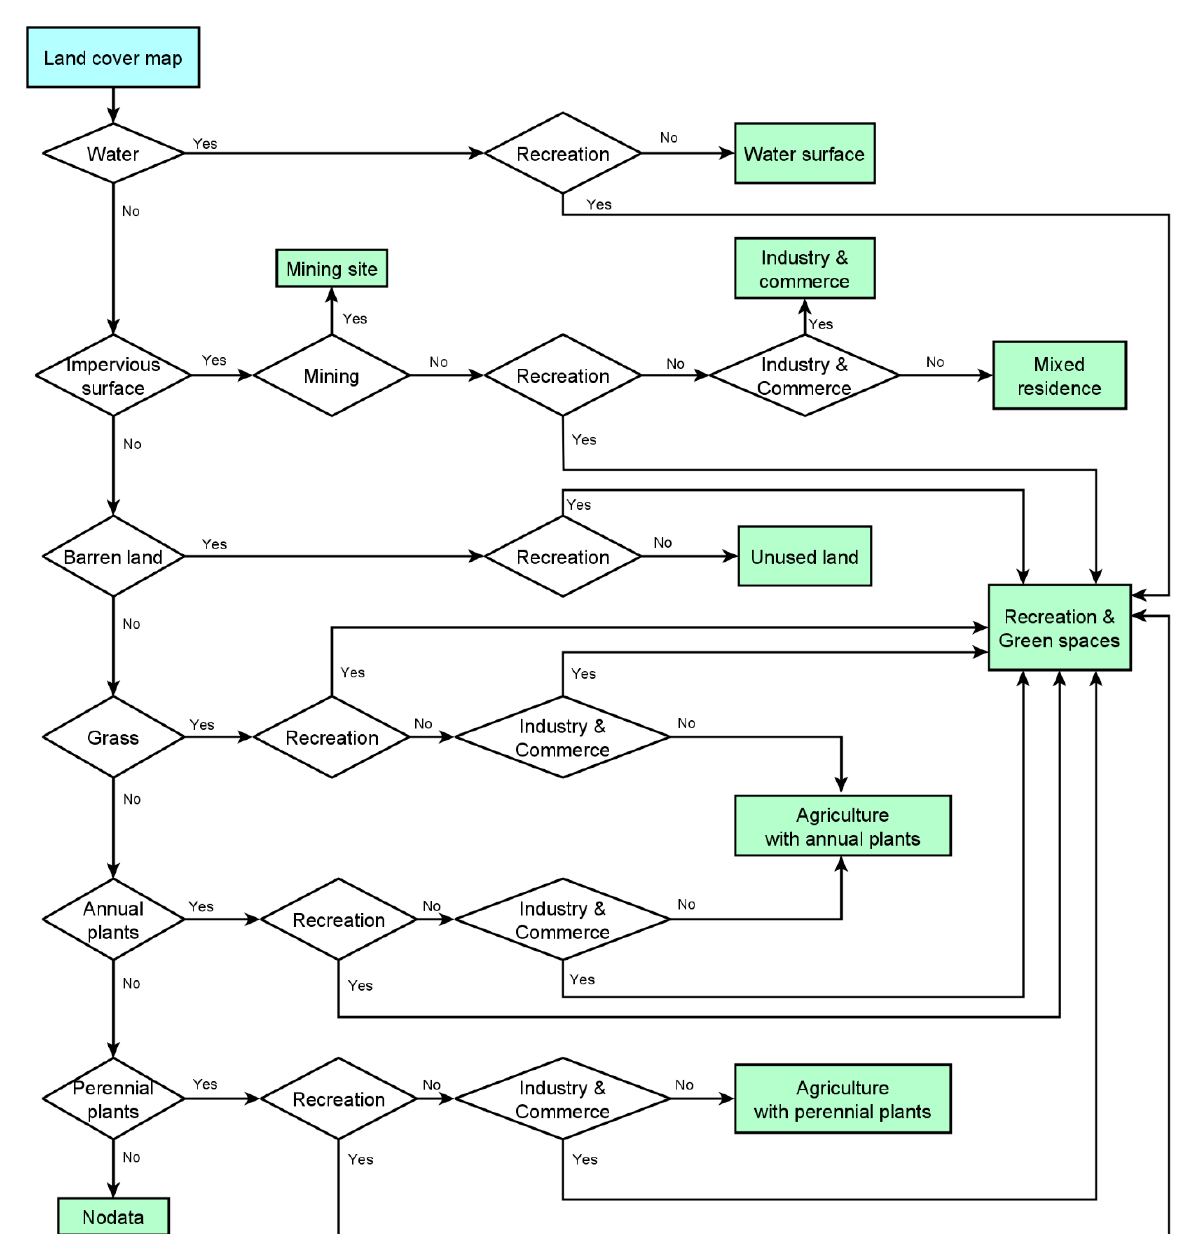
Figure 7. Decision rules for producing the land use map.